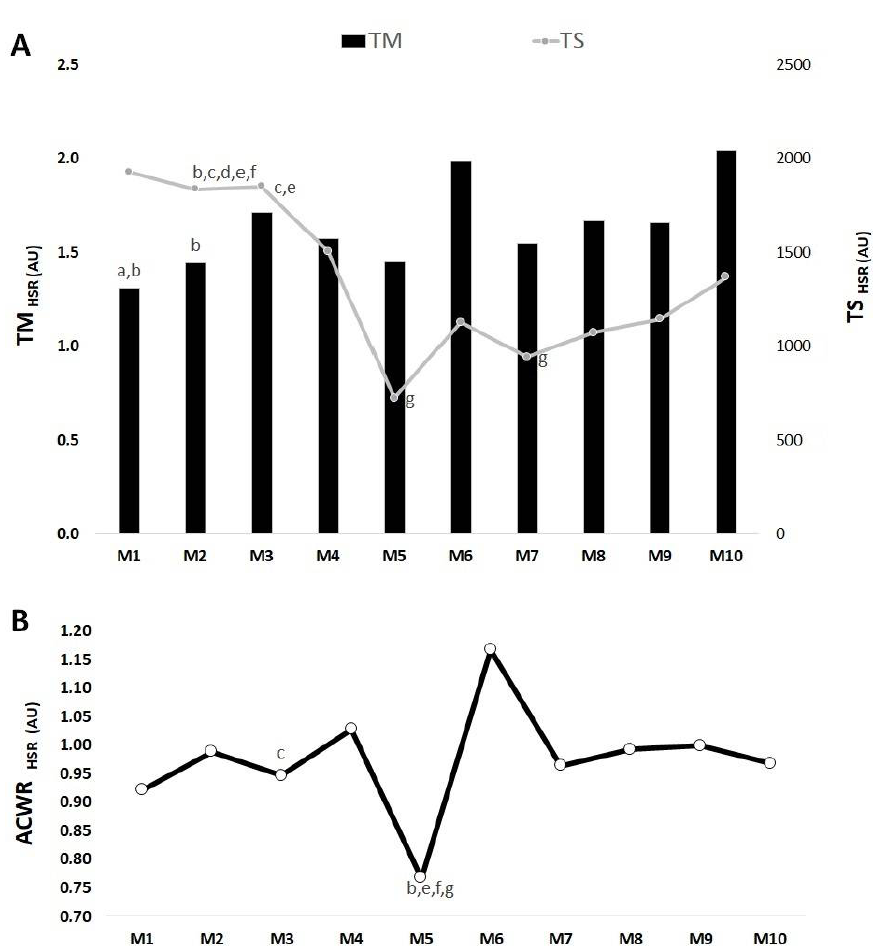
Figure 6. TM, TS ( A ) and ACWR ( B ) variations calculated through the HSR across 10 mesocycles for the whole team. M: mesocycle; a: difference from M3; b: difference from M6; c: difference from M5; d: difference from M7; e: difference from M8; f: difference from M9; g: difference from M10.